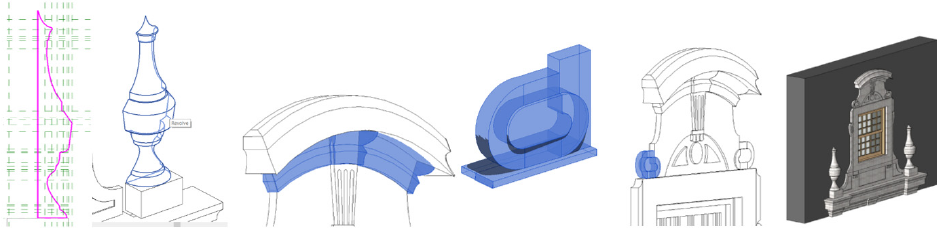
Figure 17. Modelling of decorative stonework elements around the window.